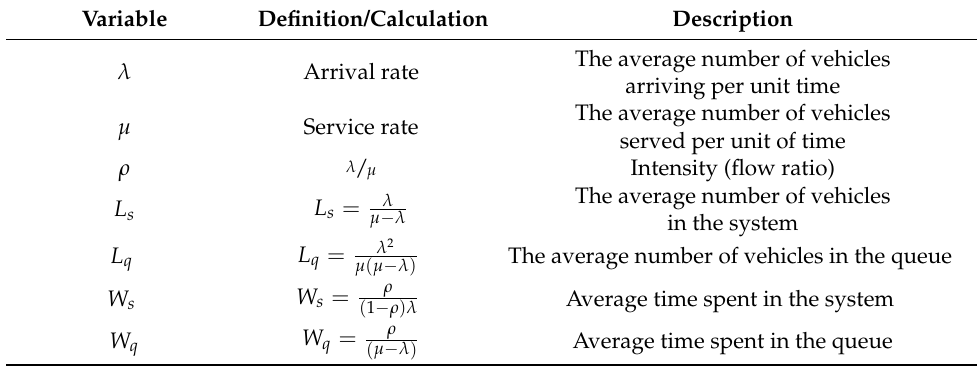
Table 3. Description of relevant parameters of queuing